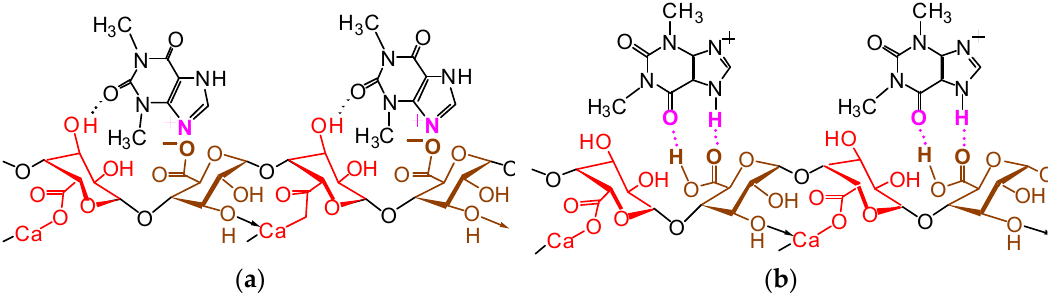
Scheme 4. Type of intermolecular interactions during theophylline sorption by pectin: ( a ) pH 5; ( b ) pH 2 ( C ‒ form is marked by a red color; N ‒ form is marked by a brown color; ionic interactions and hydrogen bonds are marked by a magenta color).